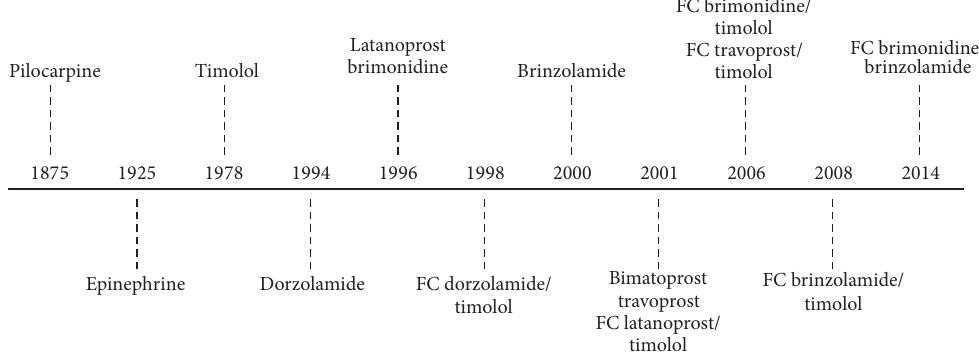
Figure 4: The chronology of the introduction of topical IOP-lowering medications. Systemic carbonic anhydrase inhibitors have been available since